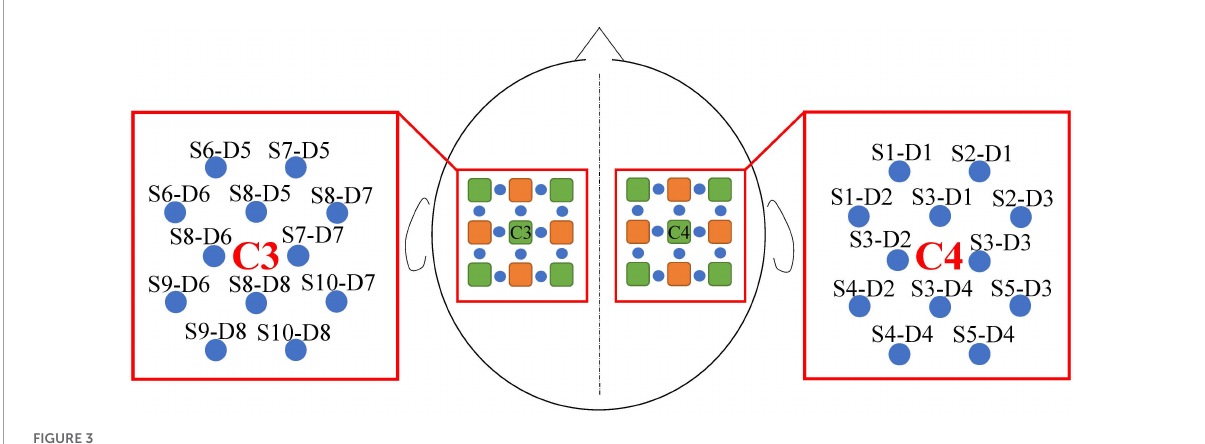
FIGURE3 Channel distribution and designation. The fNIRS sources are green and fNIRS detectors are orange. The blue circles represent the fNIRS channels constructed by the source and detector, the names of which were S and D. In addition, S indicates the fNIRS source and D indicates the fNIRS